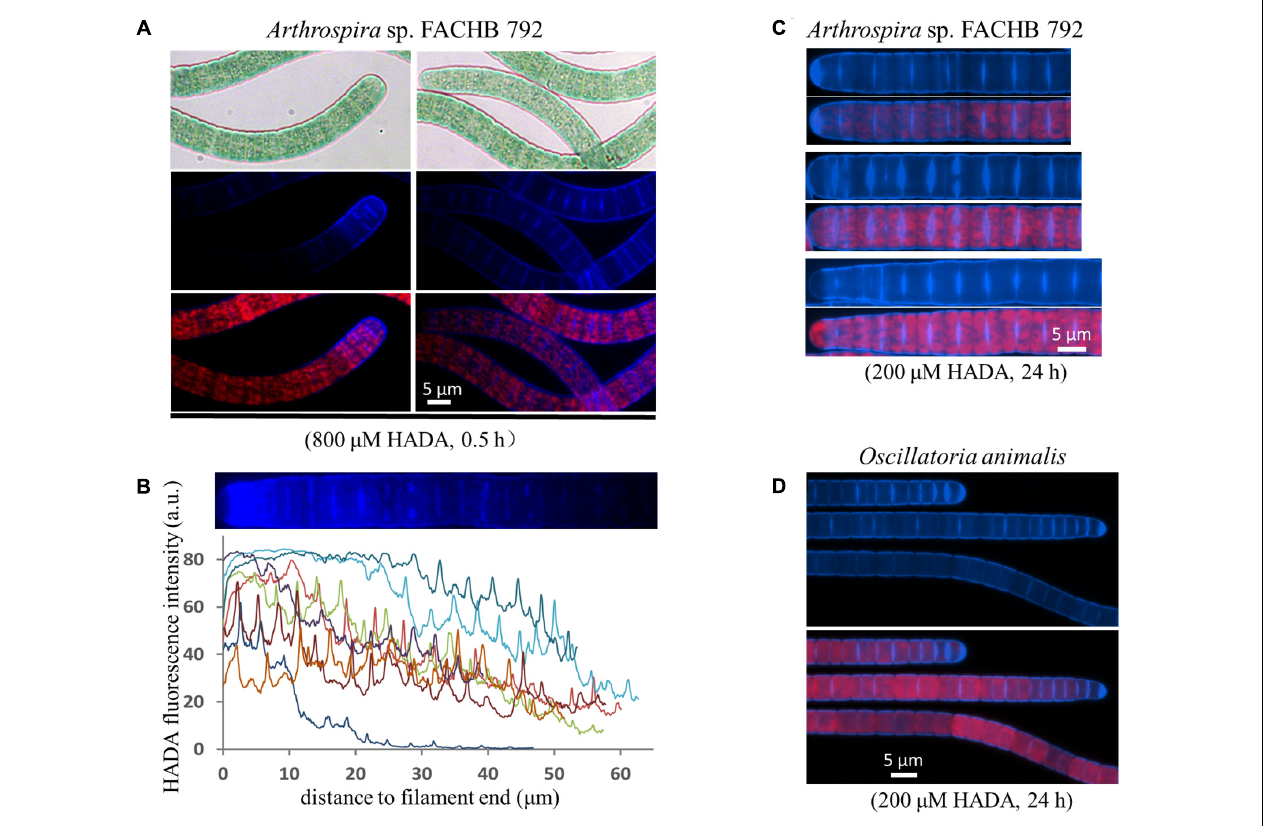
FIGURE 2 | Growth pattern of the filamentous cyanobacteria Arthrospira sp. FACHB 792 and Oscillatoria animalis . (A,C) Arthrospira pulse-labeled with 800 µ M of HADA for half an hour or long-term labeled with 200 µ M of HADA for 24 h. (B) The HADA signal at the tips of some pulse labeled Arthrospira quantified with ImageJ. Every curve in the graph represents the fluorescence intensity along one end of a filament as exemplified above the graph. The filaments of long-term labeled Arthrospira were straightened with ImageJ. (D) Oscillatoria incubated with 200 µ M of HADA for 24 h. Bright-field photos (gray background pictures in panel A), as well as images of HADA fluorescence (blue), photosynthetic pigment fluorescence (red), and their merges are